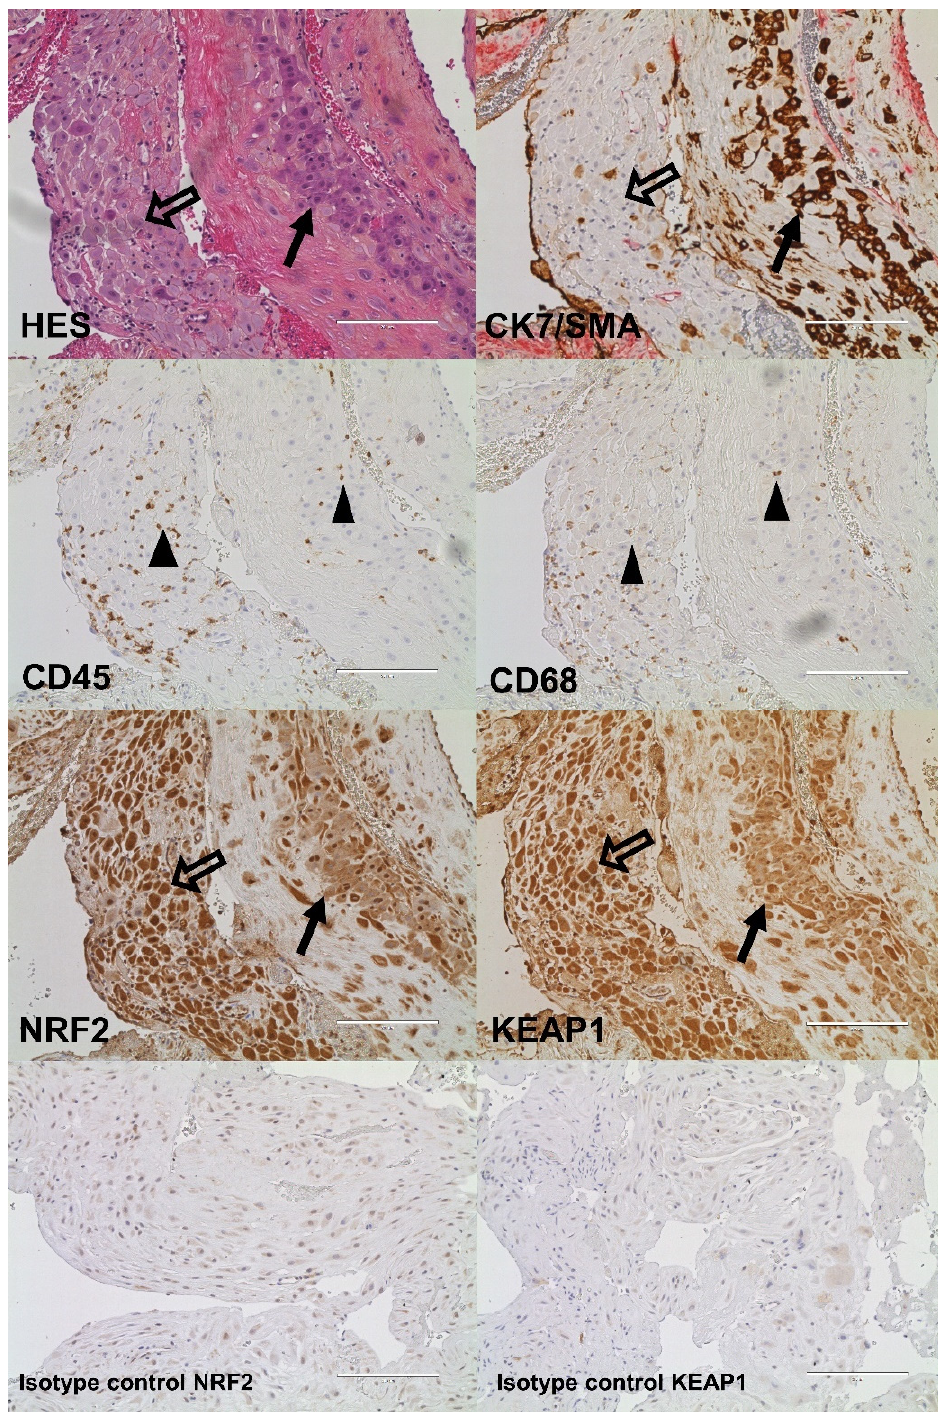
Figure 2. Decidual tissue from a preeclamptic pregnancy without fetal growth restriction stained as indicated with hematoxylin and eosin (HES) and markers for trophoblasts (cytokeratin 7 (CK7)), leukocytes (CD45), macrophages (CD68), nuclear factor erythroid 2-related factor 2 (NRF2), Kelch- like ECH-associated protein 1 (KEAP1), or negative isotype controls (20× magnification). CK7 was counterstained with smooth muscle actin (SMA). Black arrows indicate trophoblasts, transparent arrows indicate maternal decidual stroma cells, and black triangles indicate maternal leukocytes. Scale bar: 200 µM.